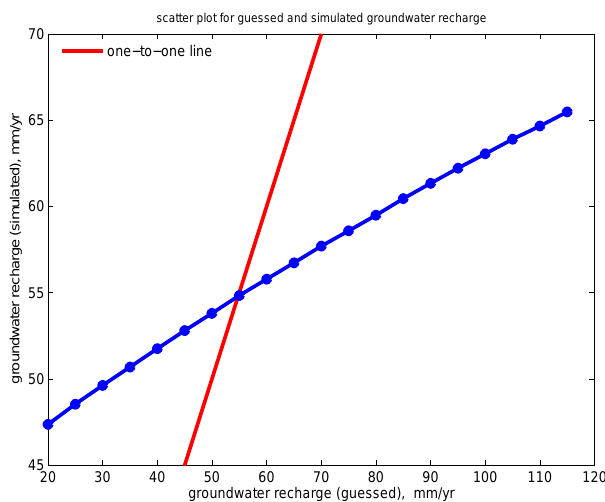
Figure 5. Parameterized (guessed) groundwater recharge versus recharge simulated in CLM 4 (see Sect. 2.3). The x axis repre- sents the trial recharge used in Eq. (4) to obtain GW WD and the y axis represents the output recharge from Eq. (3). The intersection of the parameterized values with simulated values (55mmyear − 1 ) represents where recharge comes to convergence and is the value of recharge used to separate total water use into ground- and surface- water pumping